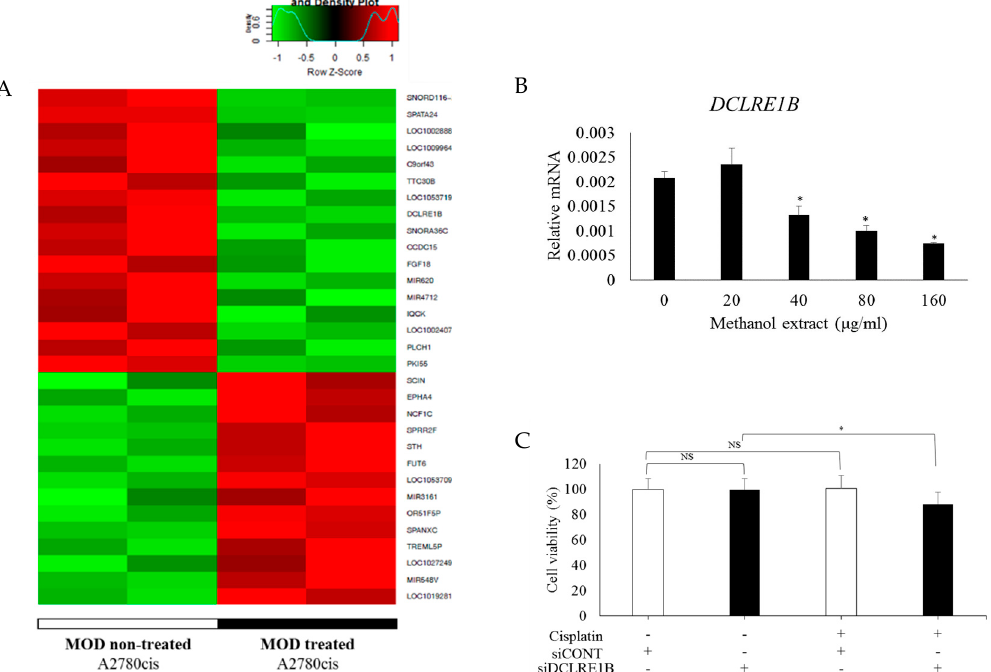
Figure 4. MOD treatment increases the sensitivity of cisplatin in CRC through downregulation of DCLRE1B . ( A ) Differentially expressed genes (DEGs) between non-treated and MOD treated A2780cis cells were represented in a heatmap. The 31 genes were identified as DEGs. Expression of 14 genes increased and 17 genes decreased in MOD treated cells using a cutoff standard of FC > |1.5| and p -value < 0.05. After treatment of A2780cis cells with MOD in various concentration (0 and 160 μ g/mL) for 48 h, ( B ) DCLRE1B mRNA expression, ( C ) transfection of A2780cis with control siRNA (siCONT) and DCLRE1B-targeting siRNA (siDCLRE1B) followed by cisplatin treatment for 48 h. Cell viability was measured with MTT assays. Data are shown as the mean ± STDEV. Significant differences between non-treated and treated groups was assessed using the Student’s t-test. * p < 0.05 was used to define statistical significance. NS: not significant.